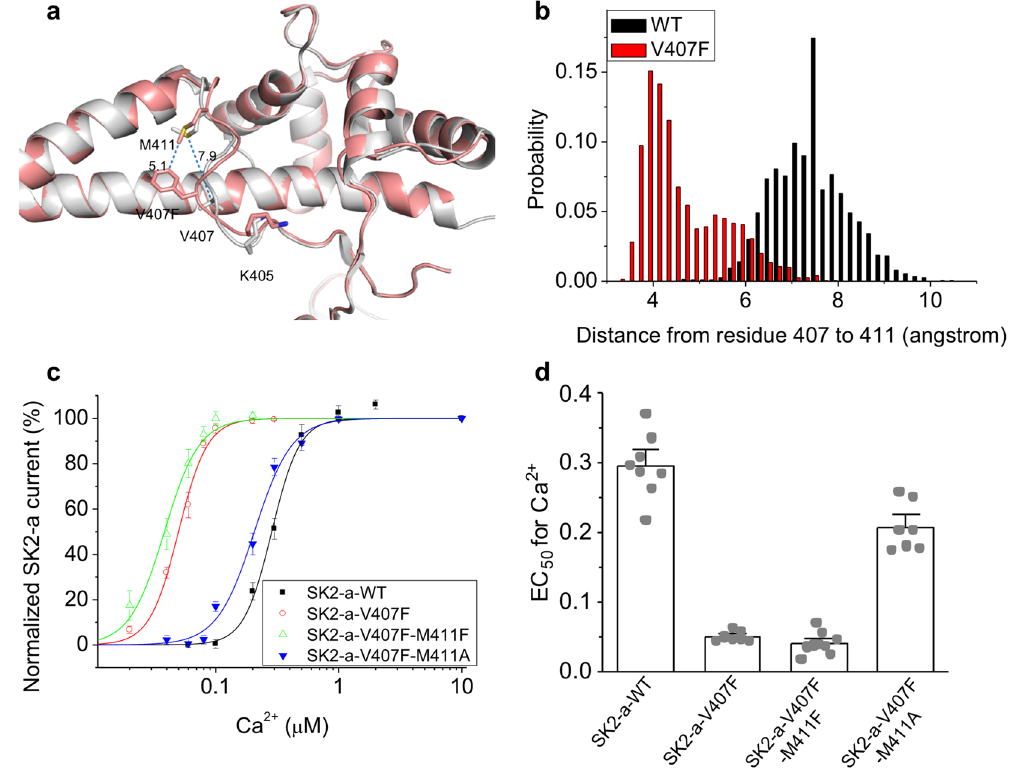
Figure 4. V407F interacts with M411. ( a ) Local conformational changes in the IDF of the V407F mutant crystal structure (salmon) compared to that of the WT structure (grey). ( b ) In MD simulations, the distance distribution histogram shows a shorter distance between residue 407 and residue 411 in the V407F mutant protein complex compared to the WT complex. ( c ) M411A mutation right-shifted the Ca 2 + dependent activation of the V407F mutant SK2-a channel. ( d ) M411A mutation significantly compromised the Ca 2